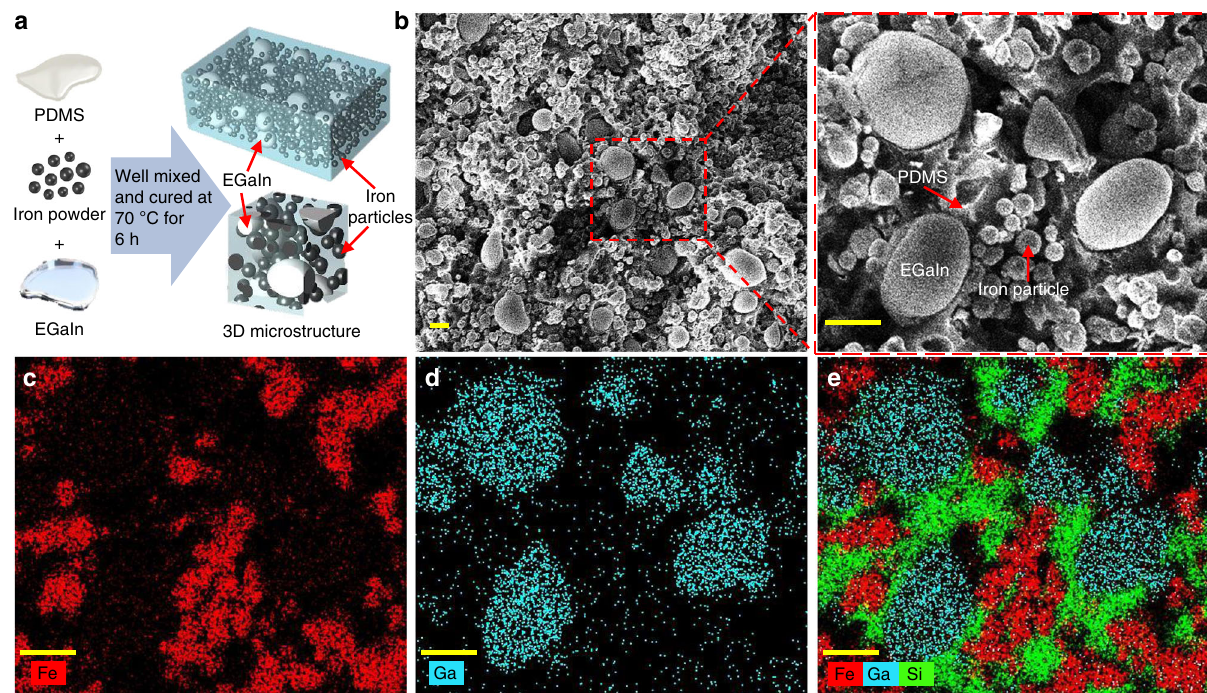
Fig. 1 Production of the liquid metal- fi lled magnetorheological elastomer (LMMRE). a Schematic of the procedure for fabricating the LMMRE. b Scanning electron microscopy (SEM) images of the obtained LMMRE. c – e Energy dispersive X-ray spectroscopy (EDS) element mappings of the LMMRE. Scale